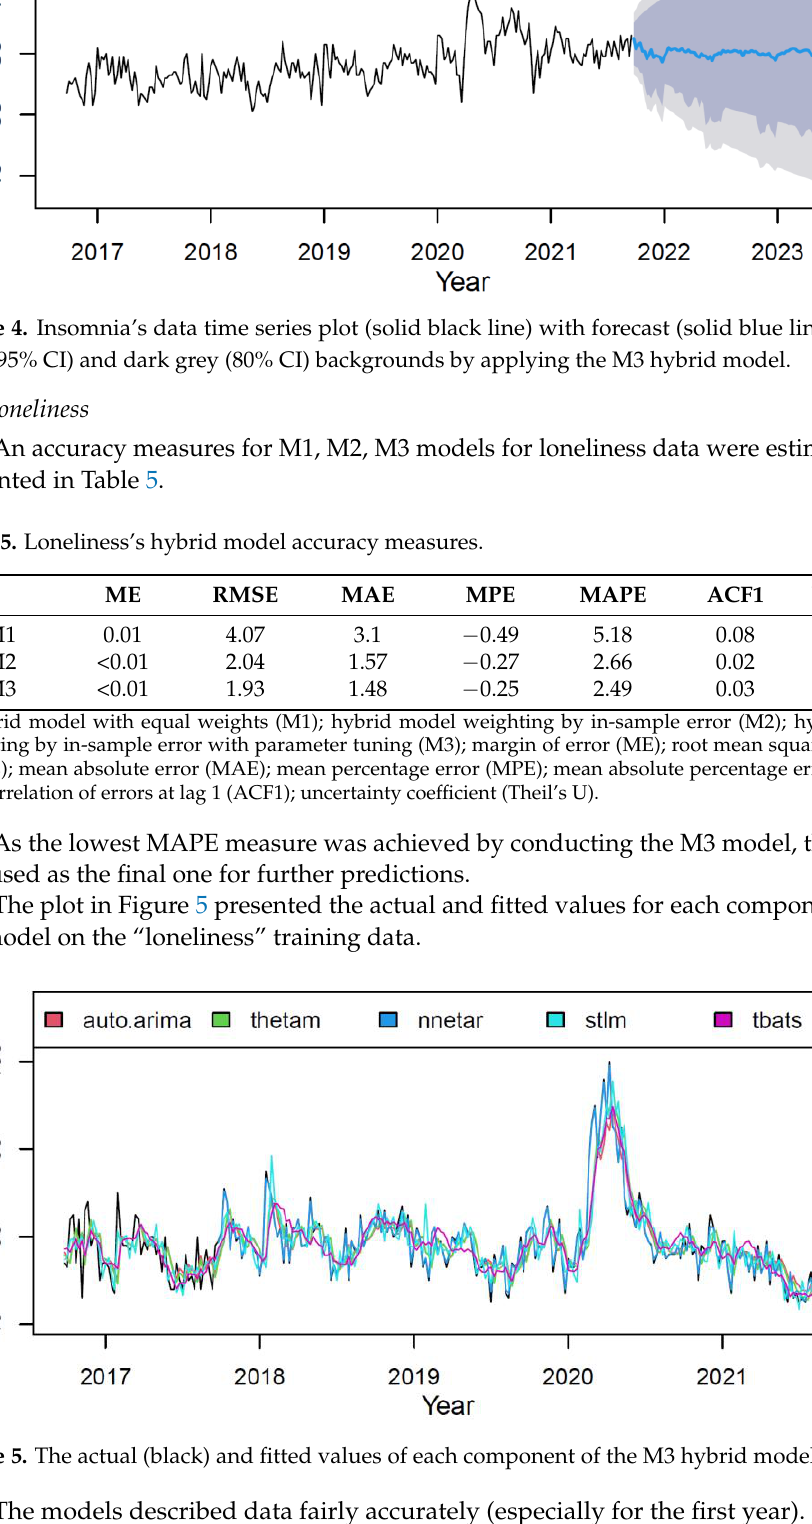
6 of 16 Figure 3. The actual (black) and fitted values of each component of the M3 hybrid model. The models described data fairly accurately. However, compared to nnetar , the rest have a slight underfitting. The model components weights, based on the quality of fitting the training data, are shown in Table 4. Table 4. The M3 model’s component weights for insomnia score forecasting .